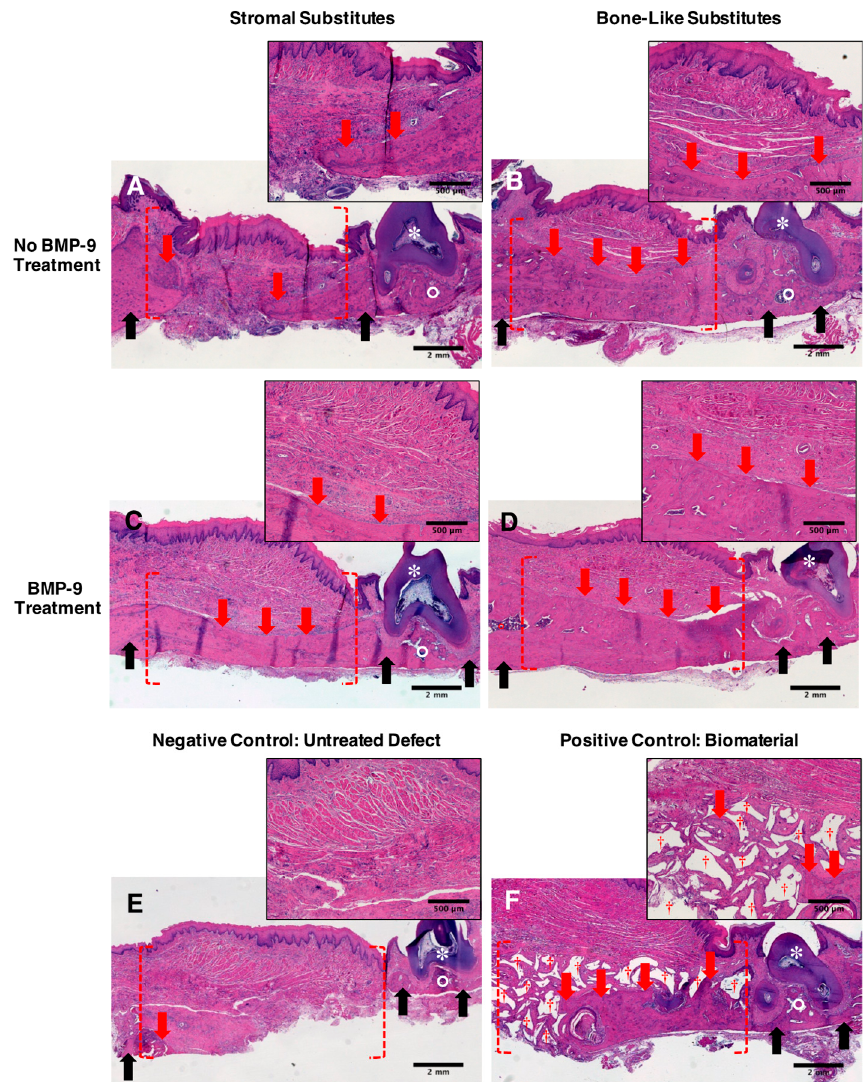
Figure 5. Representative histological observations of the grafting sites. ( A – F ) Maxillaries were harvested, fixed, demineralized, paraffin-embedded, and stained using hematoxylin and eosin dyes ten weeks after grafting of the substitutes. Implantation sites (red dashed parentheses) can be identified next to the third superior molar (white asterisks; color: dark purple). The area containing the remaining tooth is delimited by native bone (black arrows; color: purple) surrounding bone marrow (white circle color: dark purple). The new bone that is formed (red arrows; color: purple) is surrounded by dense irregular connective tissue (color: pink) and observed at the grafting sites. ( F ) The presence of empty spaces (red crosses) surrounded by newly formed bone corresponds to the presence of the demineralized biomaterial granules and was observed in the positive control group. Scale bars: 2 mm (large panels) and 500 µm (insets).